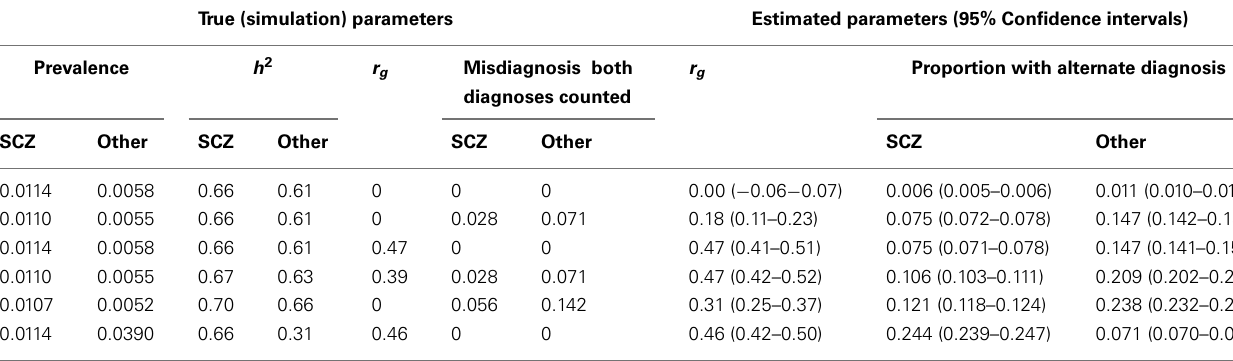
TableA2 | Simulation results with simulation parameters selected to generate estimated diagnosis prevalence rates and heritabilities based on cumulative incidences up to